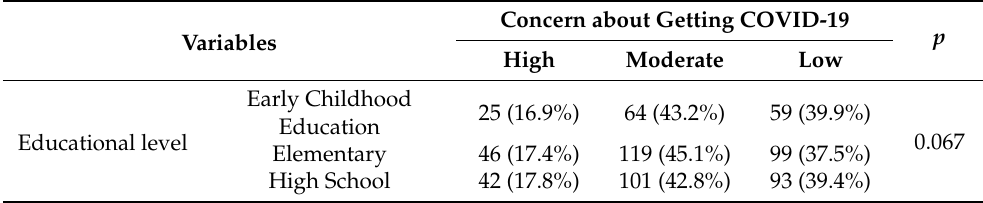
Table 5. Association between concern about the spread of COVID-19 and educational level.